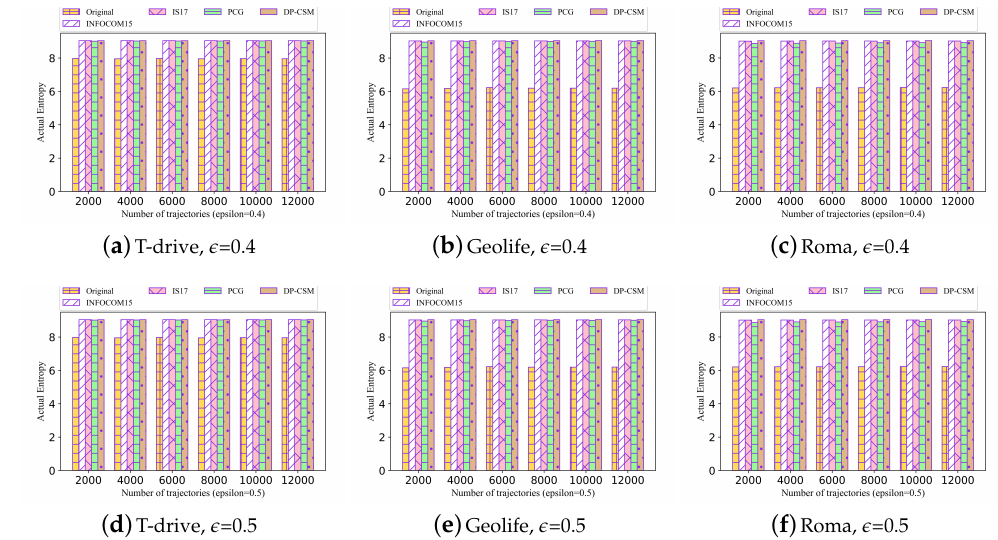
Figure 9. The actual entropy comparison of the four models under different settings. In particular, we fix k = 80 and vary the privacy budget (cid:101) and the size of trajectory datasets. For the privacy budget, we choose two kinds of values, i.e., (cid:101) = 0.4 and (cid:101) = 0.5, respectively. Under each privacy budget, we vary the sizes of trajectory